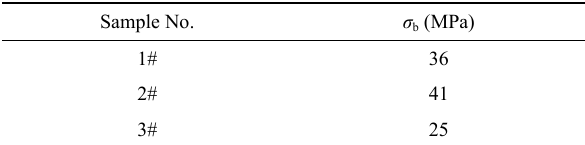
Table 5 Bonding strength of NiAl/NiCrO coating on N5 superalloy (the samples experienced post vacuum annealing)